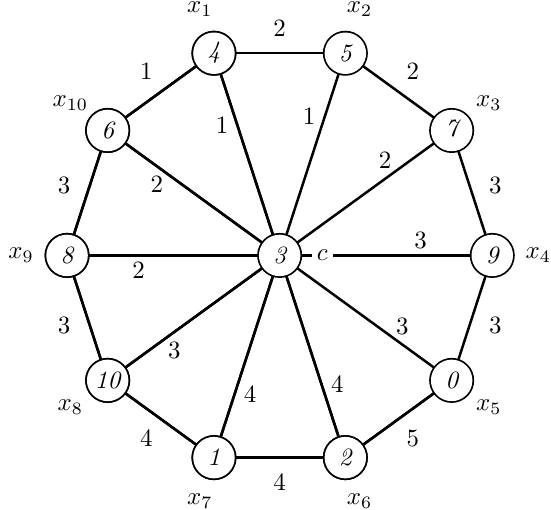
Figure 3. A modular irregular 5-labeling of W 10 .